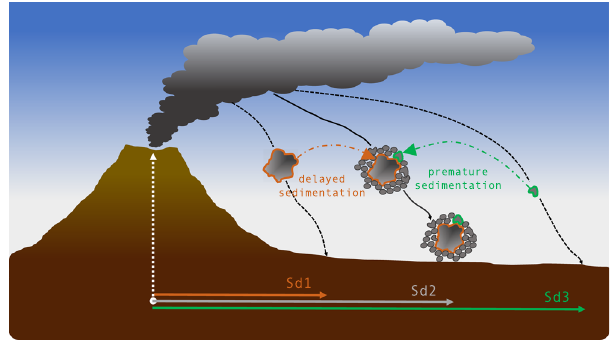
Fig. 1 Premature and delayed sedimentation. Simpli fi ed sketch showing both premature and delayed sedimentation of single particles due to aggregation. Premature sedimentation of a single particle (typically <63 microns) occurs when it falls closer to the volcano (at distance Sd2) than it would do if not part of an aggregate (distance Sd3). On the contrary, a particle that acts as an aggregate core in a cored cluster could be rafted and sediment at larger distance from vent (Sd2) than if it was falling individually (distance